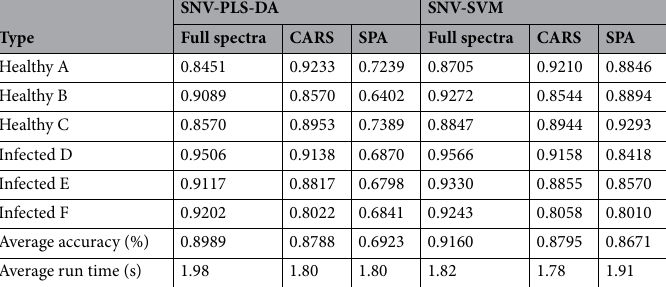
Table 4. Discrimination results of the PLS-DA and SVM models based on SNV preprocessing under band screening and full spectrum (Accuracy